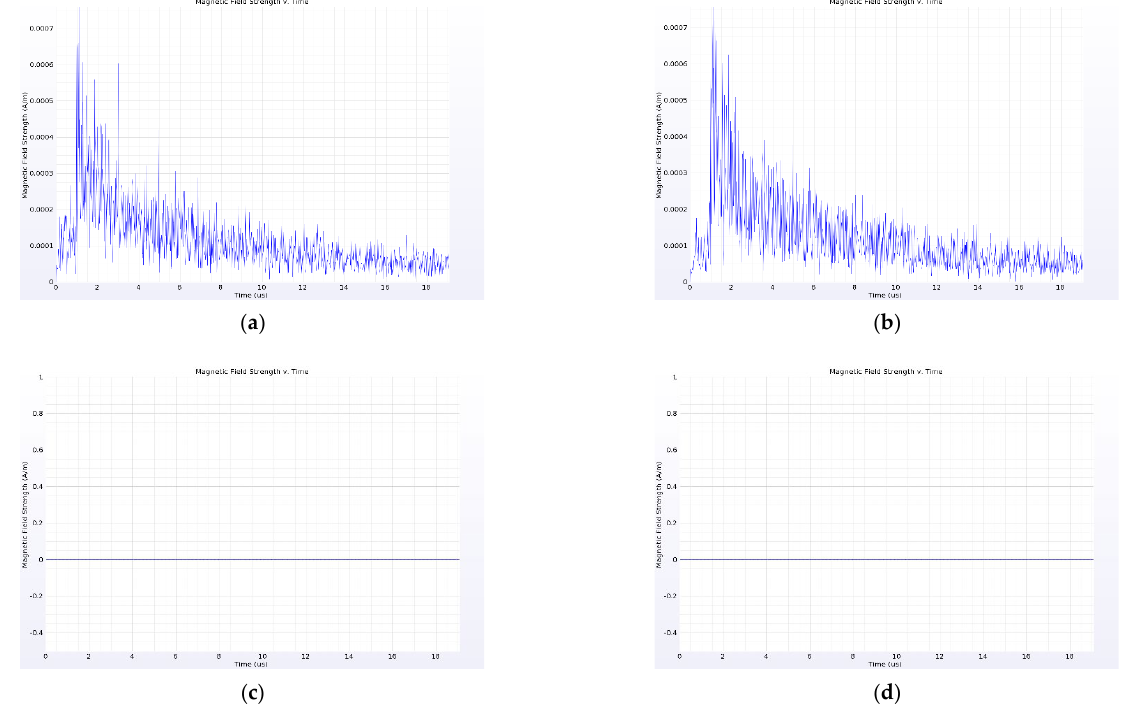
Figure 16. Effect of switchgear wall on near - field propagation characteristics of PD electromagnetic wave signal. ( a ) magnetic field strength at point sensor 1; ( b ) magnetic field strength at point sensor 2; ( c ) magnetic field strength at point sensor 3; ( d ) magnetic field strength at point sensor 4. It can be seen from Figure 15 that when the PD electromagnetic wave signal is just transmitted, the electric field intensity amplitudes observed by point sensors 1 and 2 are 1.5833 V/m and 0.5713 V/m , respectively. However, point sensors 3 and 4 outside the magnetic field intensity amplitudes observed by point sensors 1, 2, 3 and 4 are 0.00075895 A/m, 0.00075601 A/m, 0 A/m and 0 A/m , respectively. It can be seen from the above two figures that the PD electromagnetic wave signal cannot be detected by the sensor outside the switchgear. This is because the 𝜎𝜎 𝜔𝜔𝜔𝜔 = 0.019 of the switchgear body is a general conductive medium, and the influence of the conduc- tive current cannot be ignored. That is, in this transmission process, the Joule heat of the signal in the conductive medium and the refraction and reflection phenomenon of the composite interface will bring attenuation to the amplitude of the signal. Therefore, if the PD electromagnetic wave signal in the switchgear is to be well detected, the near - field probe is best placed in the switchgear. 4.5. Analysis of Placement Position of Near-Field Probe It can be seen from the simulation results in Sections 4.1 – 4.4 that the current trans- former, insulator, busbar and cabinet body in the switchgear have different effects on the PD electromagnetic wave signal itself, such as attenuation and distortion. When placing the near - field probe, it should avoid being close to the current transformer, insulator and busbar, and should be placed inside the switchgear. According to the above simulation results and the size of the switchgear, the placement positions of the near - field probe are shown in Figure 17, that is, the inner wall and the right wall near the bottom plate of the cabinet.